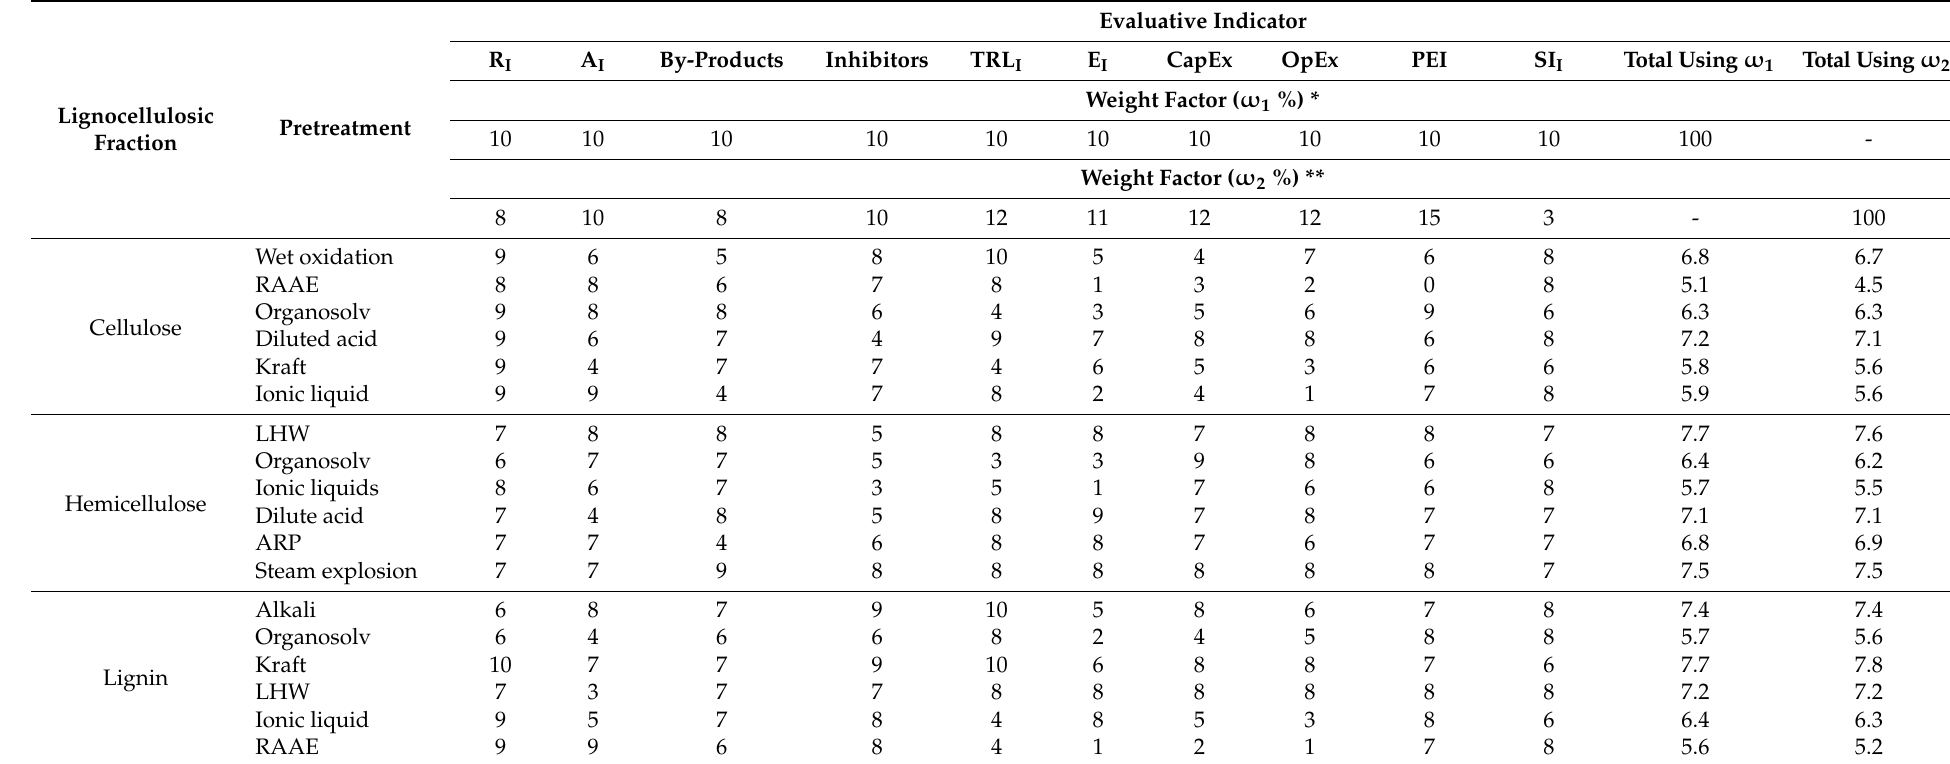
Table 7. Pretreatment efficacy by heuristic